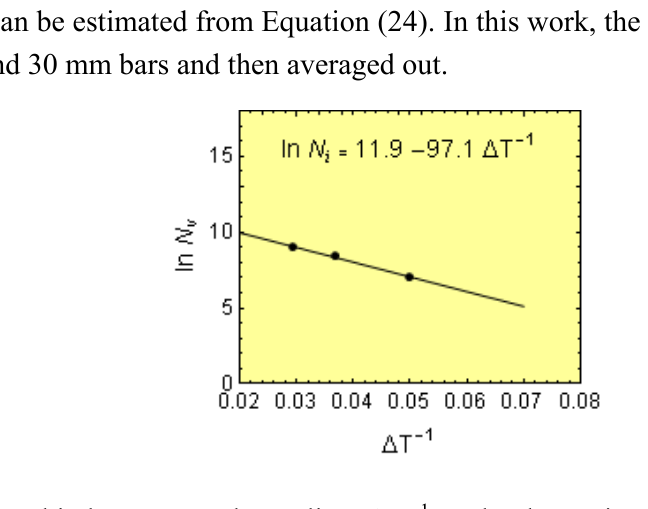
Figure 8. Relationship between undercooling,  T i −1 , and volumetric cell count, ln N i , for melt